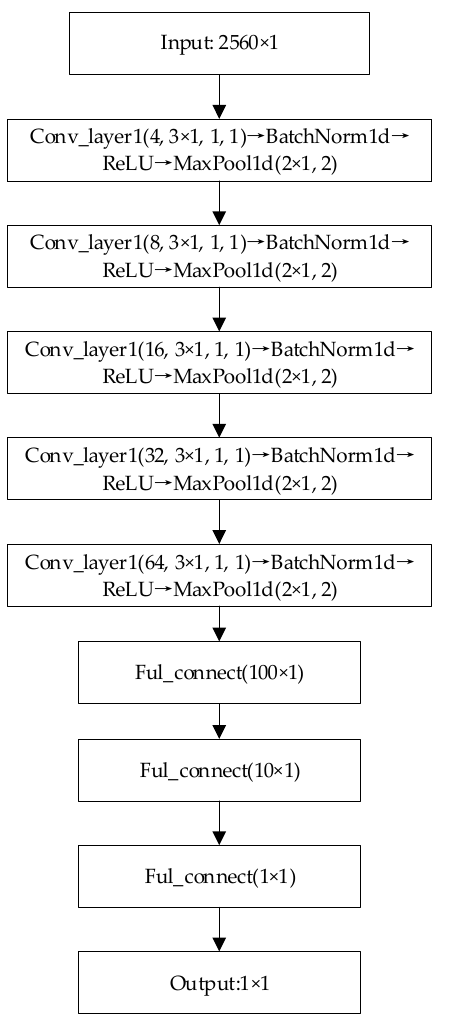
Figure 13. The structure of the 1D-CNN.